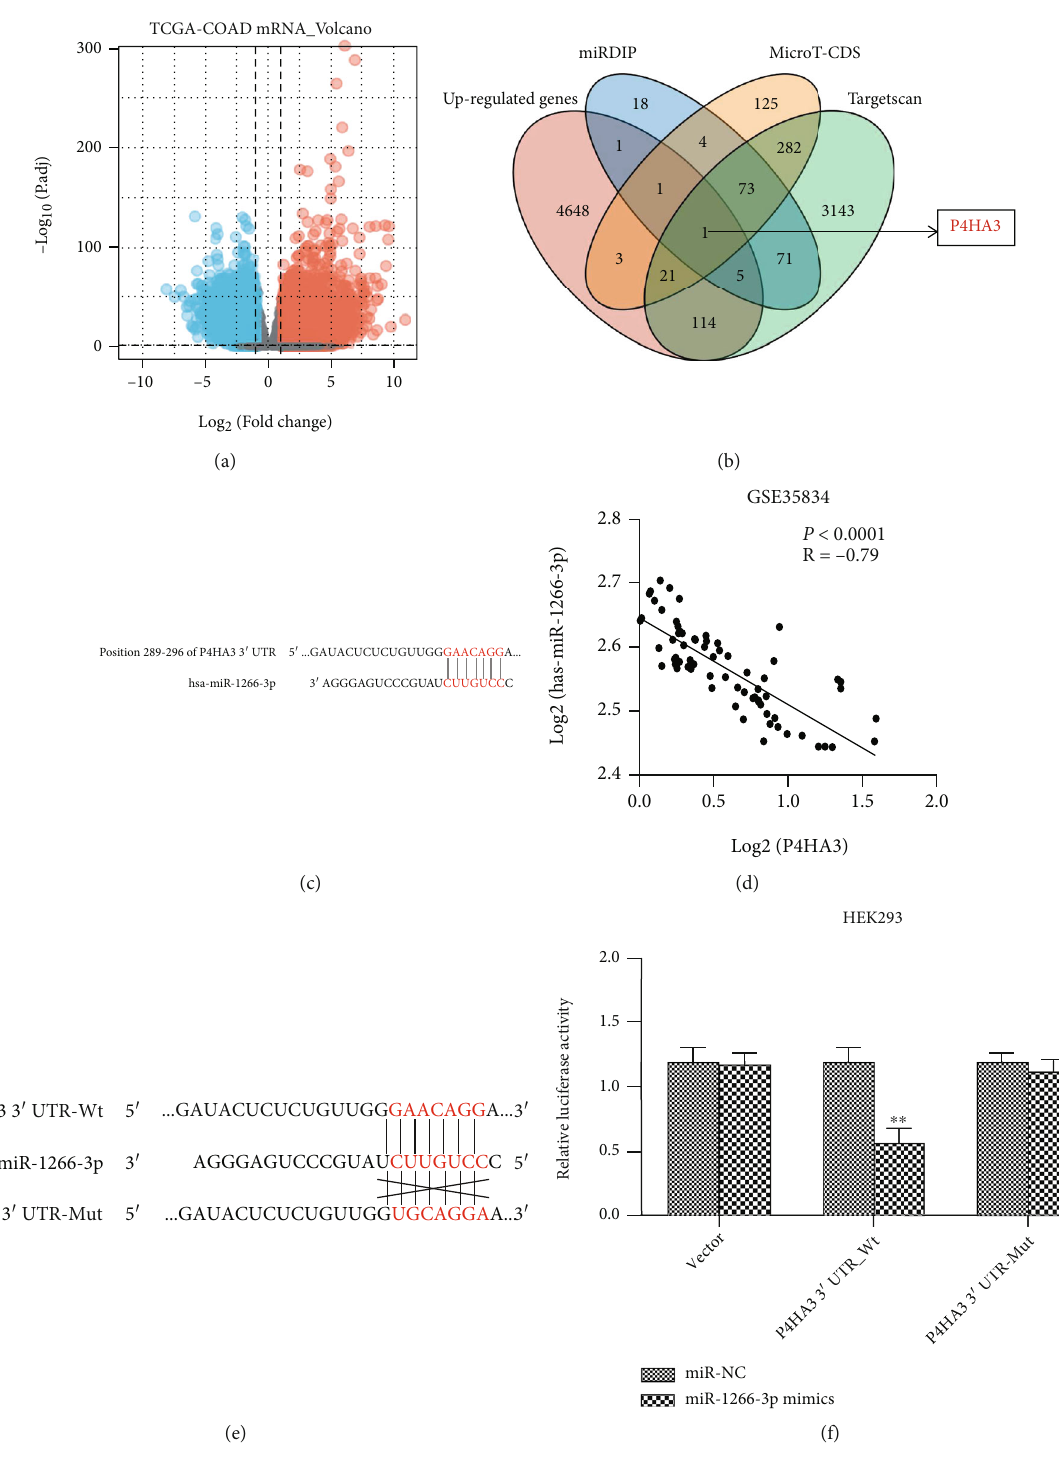
Figure 2: P4HA3 was a direct target of miR-1266-3p. (a) Volcano map of di ff erentially expressed genes in normal and tumor groups. The red ball represents upregulated gene and the blue ball mean downregulated gene. (b) Venn diagram of upregulated genes and predicted target genes. (c) A schematic diagram of miR-1266-3p at the 3 ’ -UTR predicted binding site of P4HA3 mRNA in the Targetscan database. (d) The correlation of miR-1266-3p with P4HA3 in the GSE35843 dataset was analyzed using the Pearson ’ s method ( r = − 0 : 79 , P < 0 : 0001 ). (e) Schematic diagram of the luciferase reporter vector construction for wild-type P4HA3 3 ’ UTR (P4HA3 3 ’ UTR-Wt) and miR-1266-3p-binding site mutation (P4HA3 3 ’ UTR-Mut). (f) Luciferase reporter assay of HEK293 cells cotransfected with constructed luciferase reporter vectors (P4HA3 3 ’ UTR-Wt, P4HA3 3 ’ UTR-Mut, empty Vector) and miR-1266-3p mimics or negative control mimics (miR-NC) ( ∗∗ P < 0 : 01